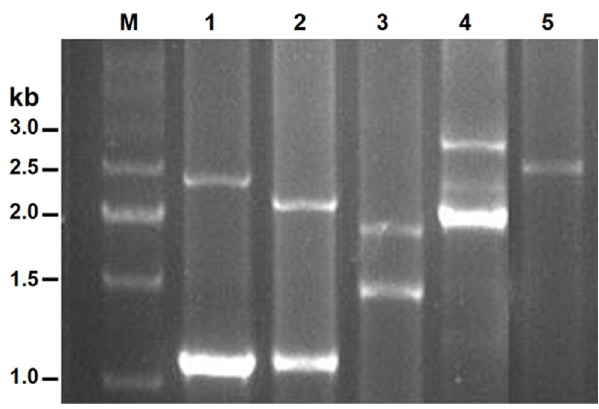
Figure 2. Representative alleles of MUC5AC-u repetitive region. MUC5AC-u repetitive regions were PCR-amplified from blood genomic DNA of case and control samples using specific unique primers. Eight alleles with discontinuous sizes ranging from 1.1 to 2.8 kb were identified in this Han Chinese population. Lane 1: 1.1 kb/2.3 kb; lane 2: 1.1 kb/2.1 kb; lane 3: 1.4 kb/1.8 kb; lane 4: 2.0 kb/2.8 kb; lane 5: 2.5 kb/ 2.5 kb. M indicated the size marker.